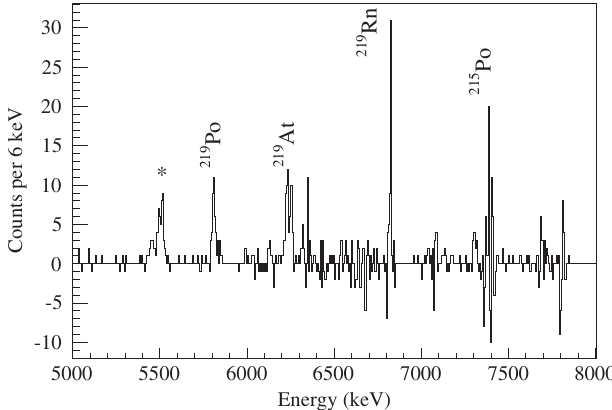
FIG. 14. Difference between the α -decay energy spectrum for mass A ¼ 219 at the implantation position with lasers tuned to a resonance of polonium and lasers off, using 100-s implantation and 180-s observation times. The peak marked with an asterisk is 222 Rn, a long-lived contaminant implanted on the laser-on carbon foil (see the text for details). The subtraction of two large peaks for 219 Rn and 215 Po, arising from the direct production of 219 Rn, results in high fluctuations in the counts around 6819 and 7386 keV.